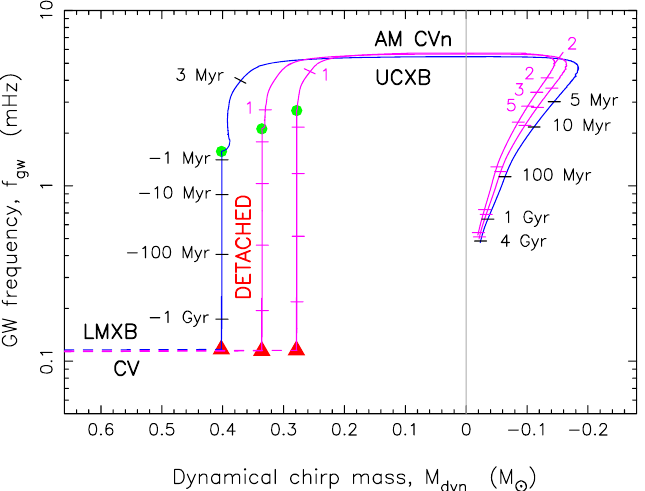
Fig. 5 GW frequency vs dynamical chirp mass for an UCXB and two AM CVn systems, based on detailed mass transfer calculations (including fi nite-temperature effects of the WD donor star) using the MESA code (Tauris 2018). The end points of the fi rst mass-transfer phases (LMXB and CV) are indicated by red triangles; the starting points of the second mass-transfer phases (UCXB and AM CVn) are indicated by green circles. The time marks along the AM CVn tracks are for the same values as indicated for the UCXB system, unless stated otherwise (in Myr). Time zero is de fi ned at the onset of the second mass-transfer phase. The maximum GW frequencies (strongest LISA signal) in these three examples are 5.45 mHz (UCXB), 5.64 mHz (AM CVn1), and 5.72 mHz (AM CVn2) corresponding orbital periods of 6.12 min, 5.91 min and 5.83 min, respectively. The frequency at the onset of the RLO (green circles) depends on the temperature of the low-mass He WD donor ( T eff = 10 850 K, 9 965 K and 8 999 K,